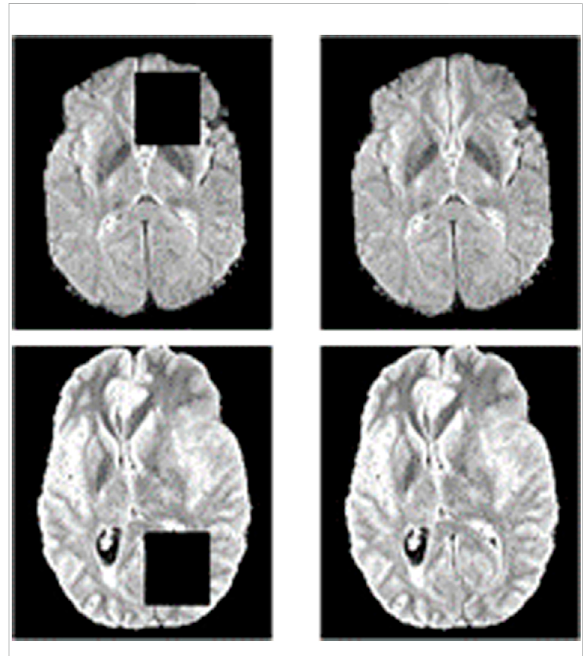
FIGURE 3 Schematic diagram of the image inpainting task. The left side istheresultofmaskingpartoftheoriginalimage,andtherightside istheoriginalimage.Theimageinpaintingtaskaimstoreconstruct the original image on the right through the input on the left.